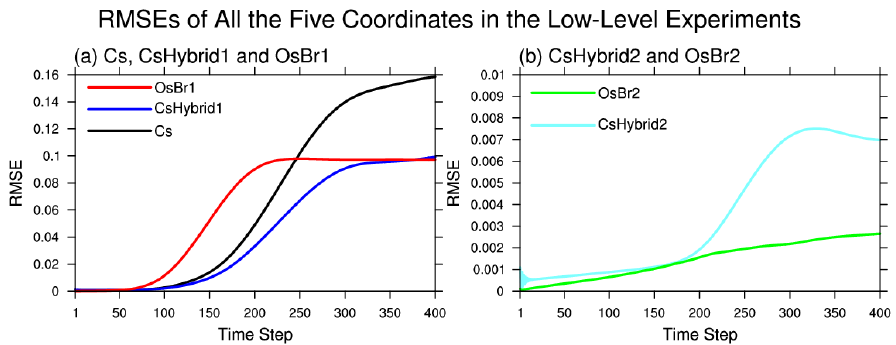
Figure 13. RMSEs of all five experiments with respect to the analytical solution in the modified Schär-type (low-level) experiments according to the time step calculated by d t =